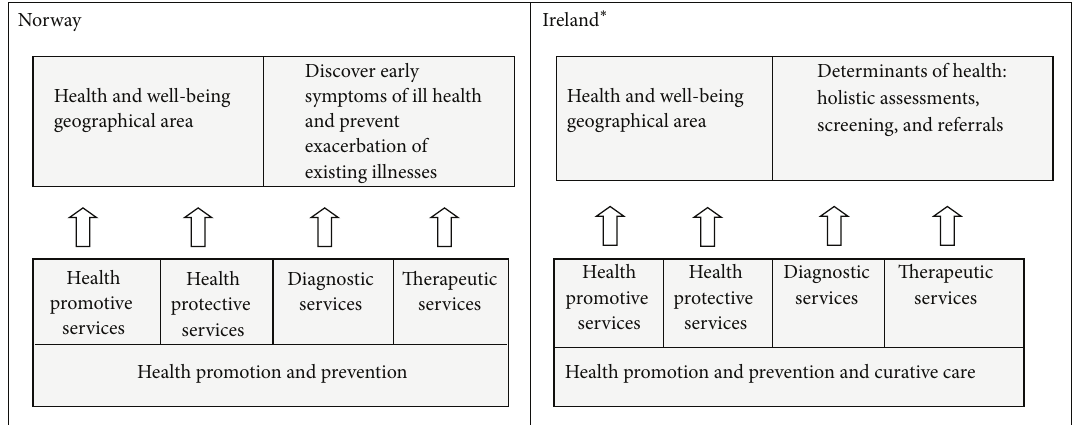
Figure 1: Adapted health promotive and preventive action model illustrating current range of services provided by PHNs in Ireland and